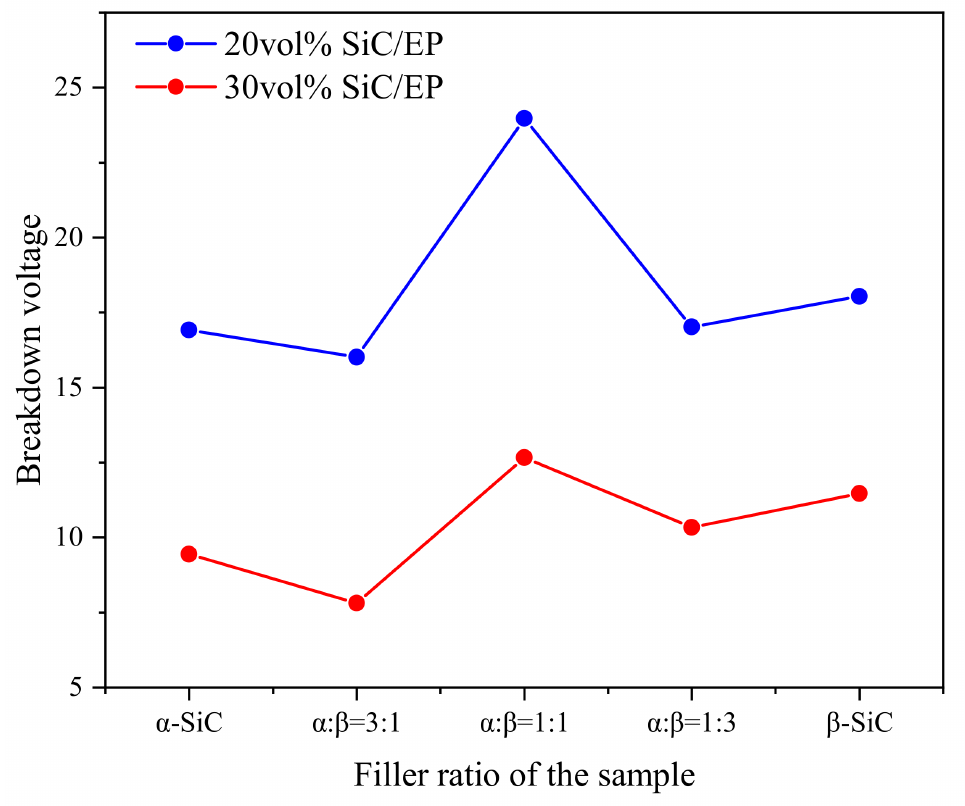
Figure 5. Average breakdown strength of composite